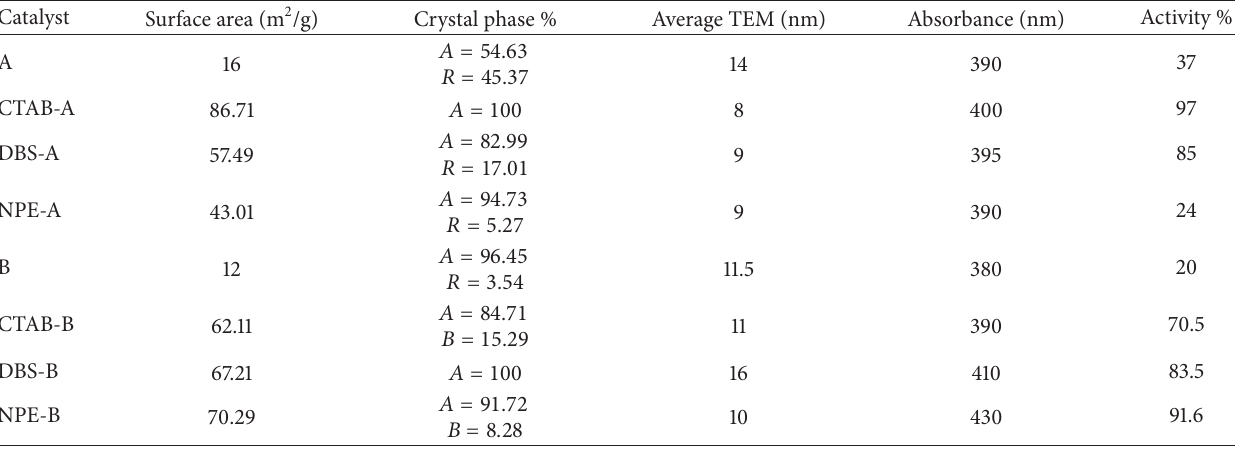
Table 1: Physical characterization of the current catalysts.